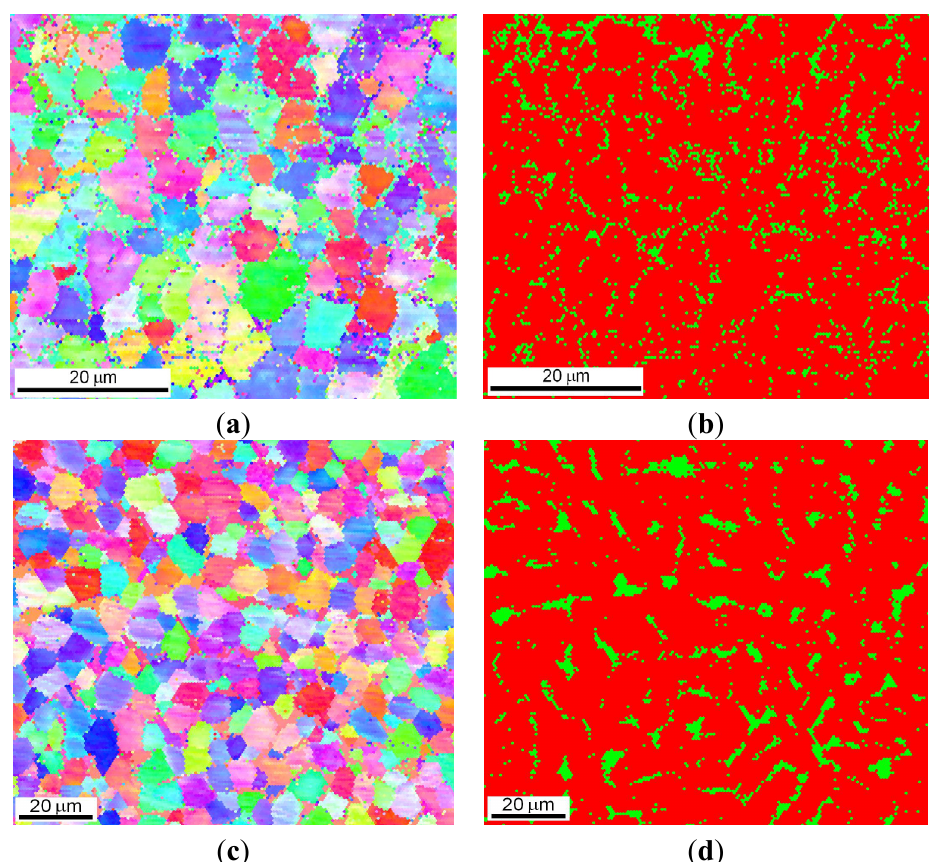
Figure 11. Microstructural characterization with OIM of sample no. 4 after laser deposition ( a , b ) and additional annealing ( c , d ); orientation maps ( a , c ) and phase composition maps ( b , d ): red color denotes the L2 1 Fe 2 TiAl Heusler phase, and green color denotes the C14 Fe 2 Ti Laves